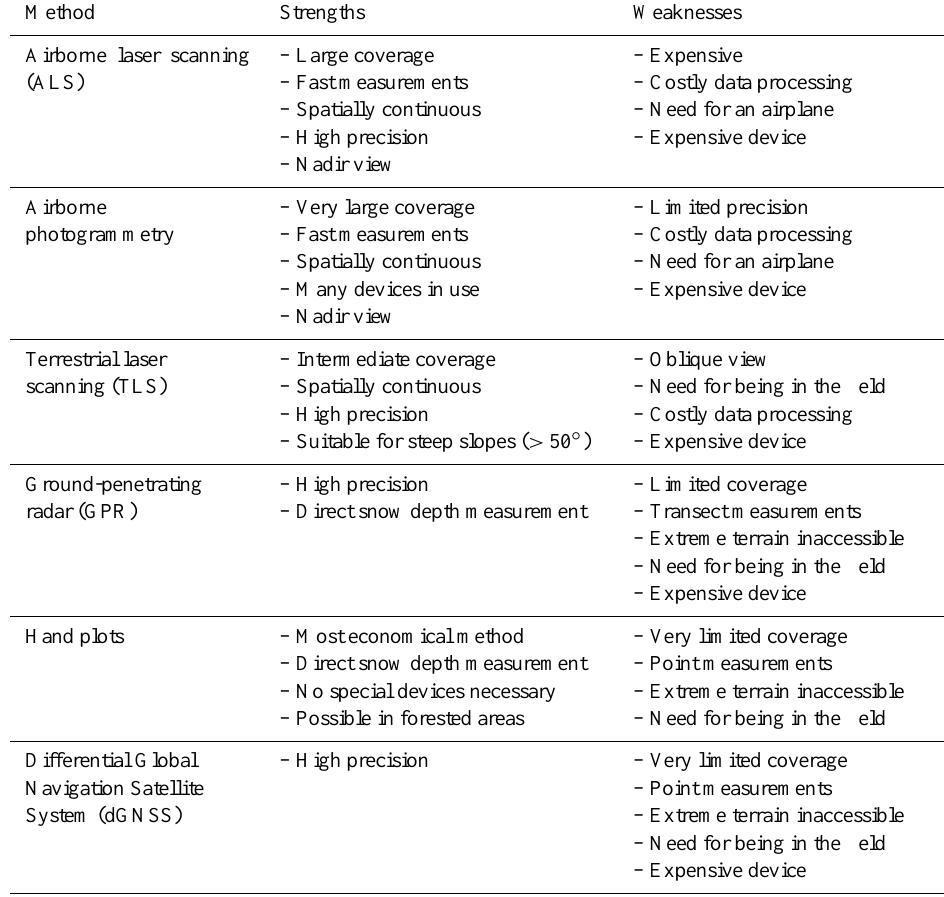
Table 6. Overview of the most important strengths and weaknesses of the applied methods for large-scale snow depth mapping in high-alpine terrain based on the experiences gained through this